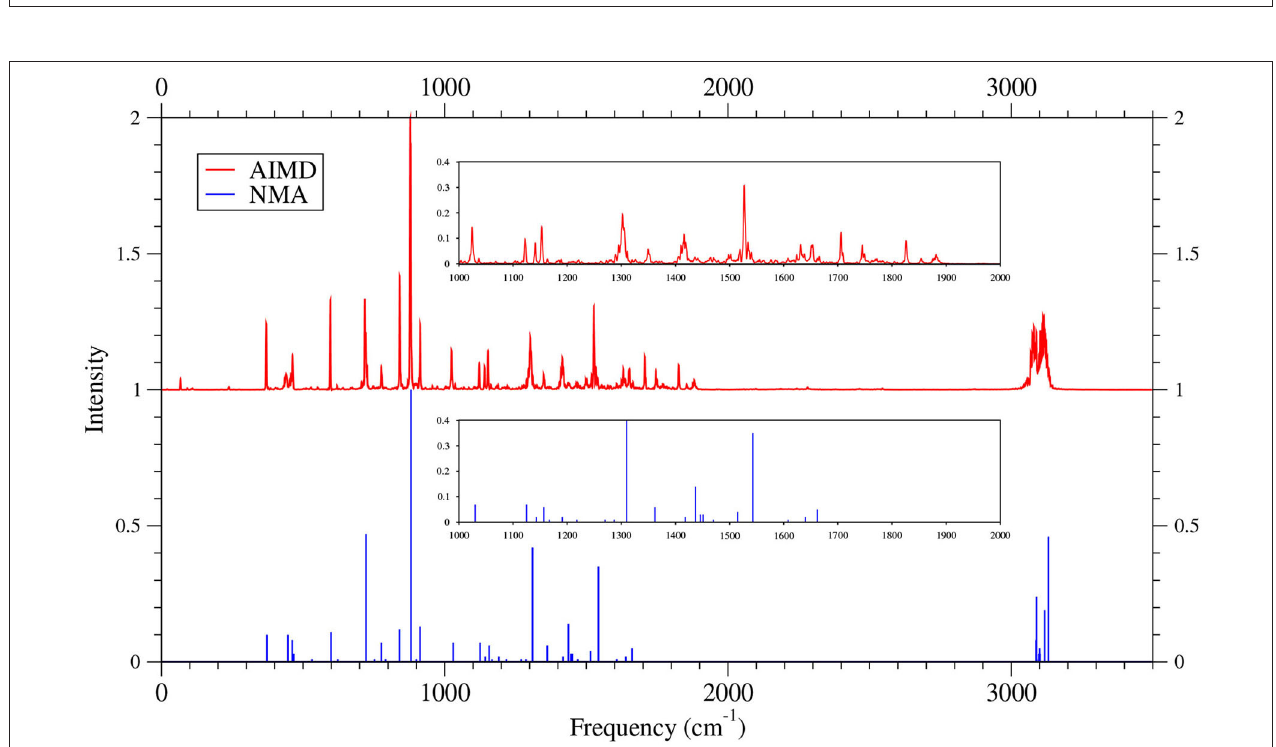
FIGURE 11 | IR spectra of 7-acene, obtained with the TAO-AIMD simulations at 300 K and GS-NMA, calculated by TAO-LDA. The IR spectra are normalized to have a maximum intensity of one and, for clarity, are vertically offset from each other by the same value. Subfigures show the IR spectra in the 1,000–2,000 cm − 1 range.